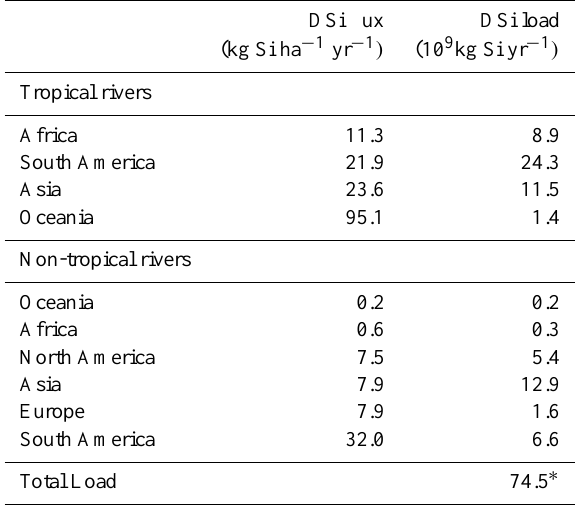
Table 5. Average DSi flux and load per continent and per latitude (tropical or not) towards large rivers. Data are from Jennerjahn et al.